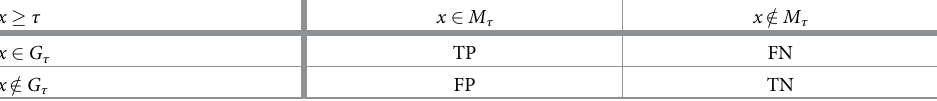
Table 2. Let a threshold, τ , define a categorization of population density. In a gold standard map, G , a pixel is in the category if it is above the threshold: x 2 G τ if and only if x > τ . Otherwise, x = 2 G τ . Similarly, the categorization is applied to a candidate map, M . Pixels are classified as true positives (TP), true negatives (TN), false negatives (FN), and false positives (FP) as described in the table. Accuracy profiles are plotted in Fig